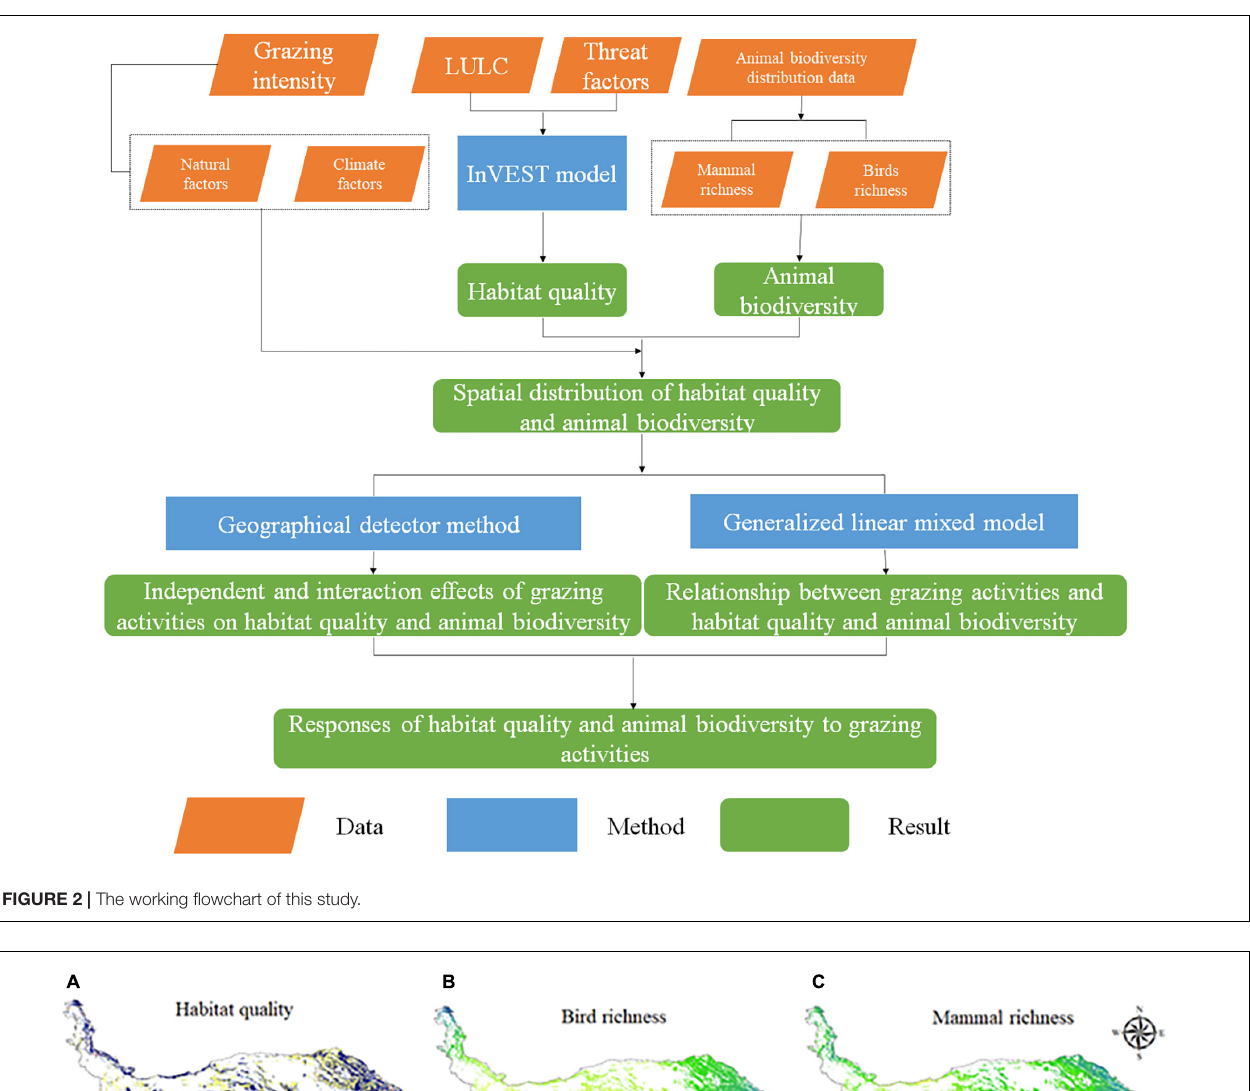
FIGURE 2 | The working flowchart of this study.